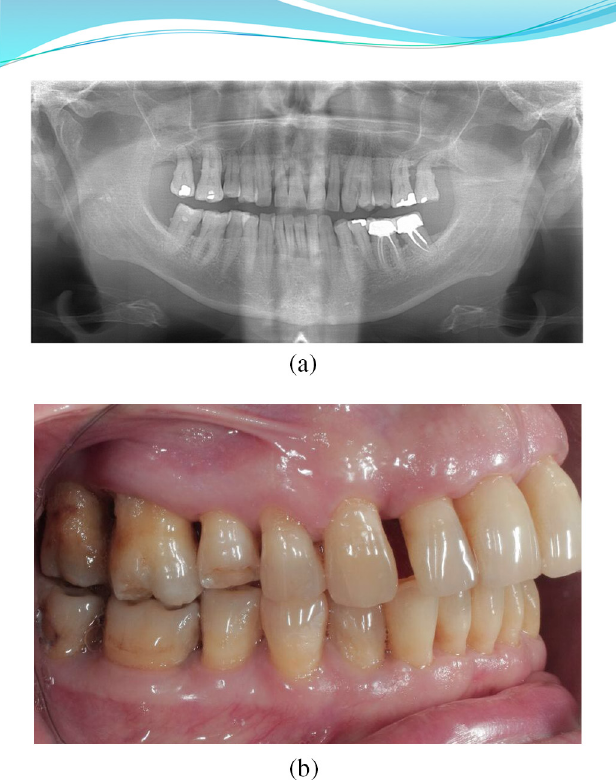
Fig. 1. (a) Panoramic view revealing horizontal (30 – 70%) and angular alveolysis of marginal bone at sites (#11, #12, #17, #27, #36). Moderate (4 – 6 mm) and severe ( > 6 mm) clinical attachment loss in sites (#16, #17, #22, #25, #26) and (# 11, # 27) respectively. (b) Preorthodontic initial view: interdental space between #12 and #13.